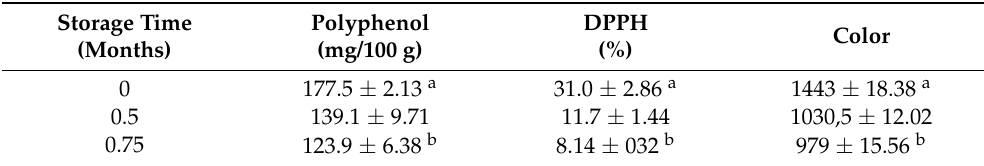
Table 5. Polyphenol content, DPPH activity, color of macerate depending on the storage time at room temperature (22–25 ◦ C).